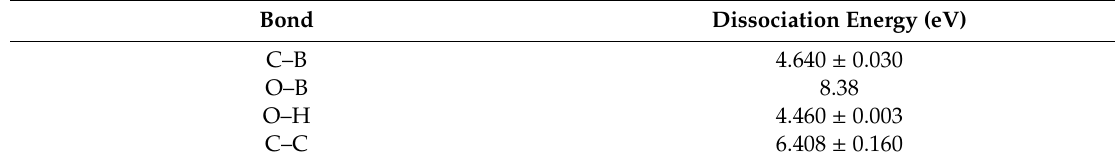
Table 3. Dissociation energies of the most relevant molecular bonds